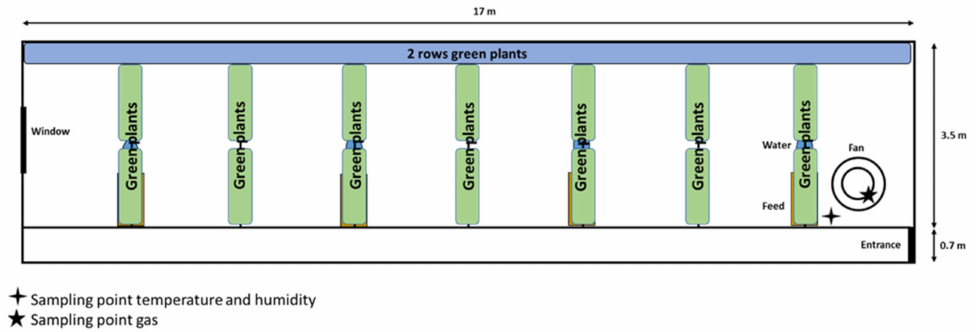
Figure 1. Drawing of the piglet compartment P. The blue area indicates where the plants were installed during the first experiment (summer–autumn), the green area indicates where further plants were installed in the second experiment